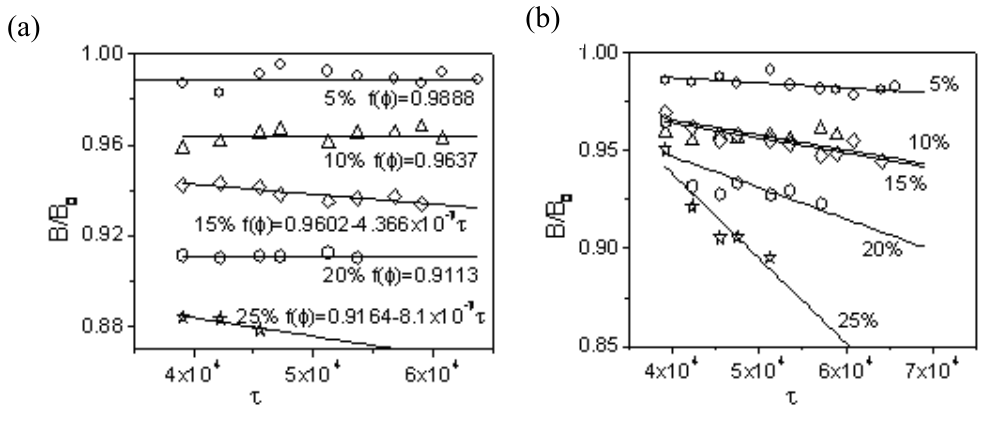
Figure 3. The die swell of iPP/stearic acid-coated (a) and uncoated (b) CaCO nanoparticles of different filler